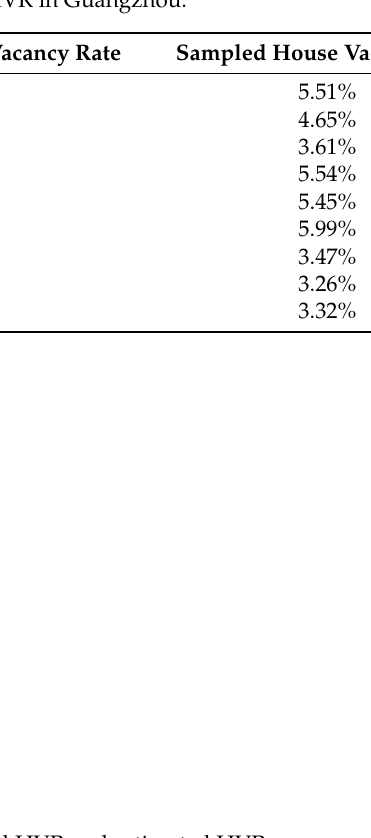
Figure 6. The linear regression between sampled HVR and estimated